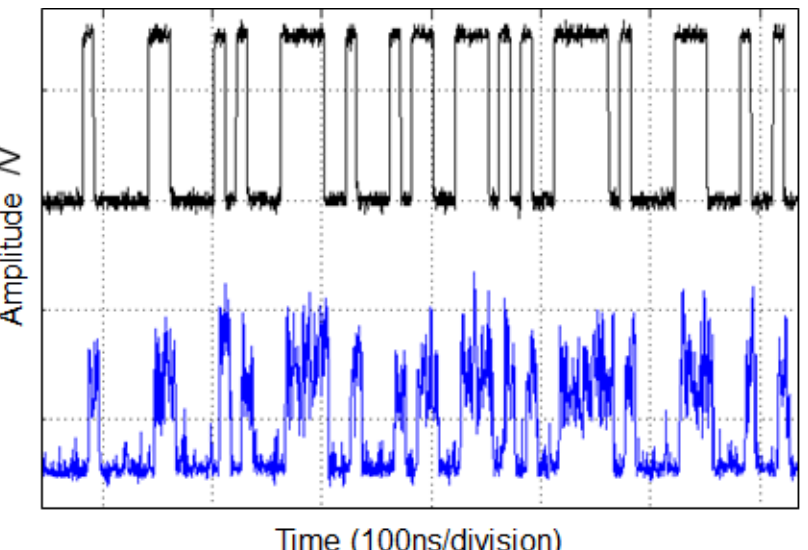
Figure 6. Typical binary OOK data bit stream at 100 Mbps, as monitored by an oscilloscope: upper plot transmitted data, lower plot is the received signal from an APD-RFE. Noise is assumed to be Gaussian-distributed with a different noise sigma for 1 s and 0 s (Figure 7). A detection threshold current level, I Thr , between the curves around the 0 s and 1 s, decides for a binary 0 and 1. Decisions to the wrong side from I Thr , will lead to bit errors. Their probability is linear to the ratio of the stippled areas A + B related to the total curve-area.